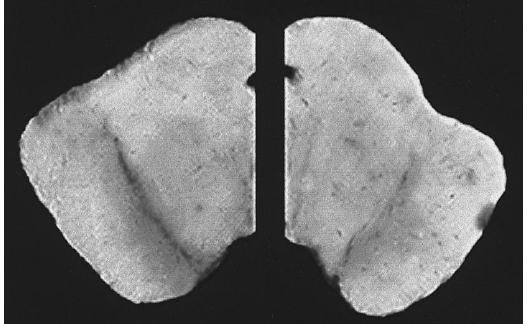
Figure 3. Melanized dopaminergic neurons of the substantia nigra from post mortem human brain. Brain sections taken through the mid- brain of a normal (left) and